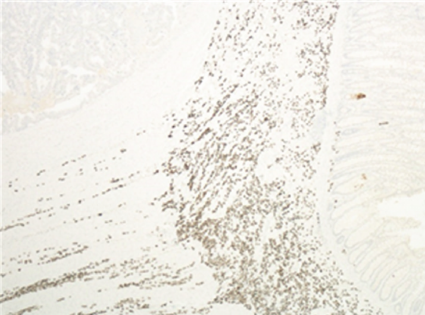
Figure 3: Immunohistochemical staining with CK 7 demonstrating negative adenocarcinoma uptake and positive metastatic carcinoma